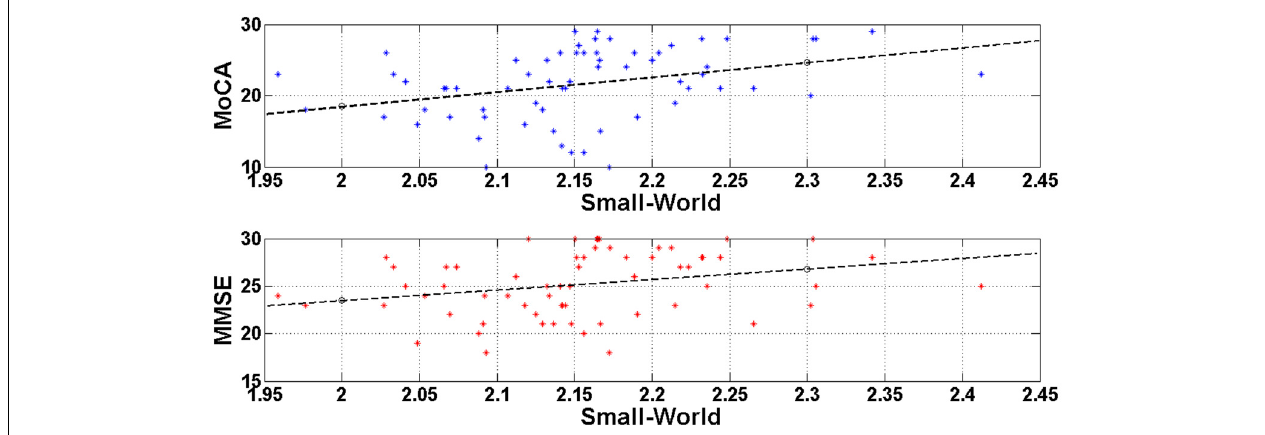
FIGURE 4 | Visualization of the linear correlation among the network architecture (Small-World) with the generic neuropsychological tests. The correlation degree was estimated through the Pearson coefficient and was greater for the MoCA